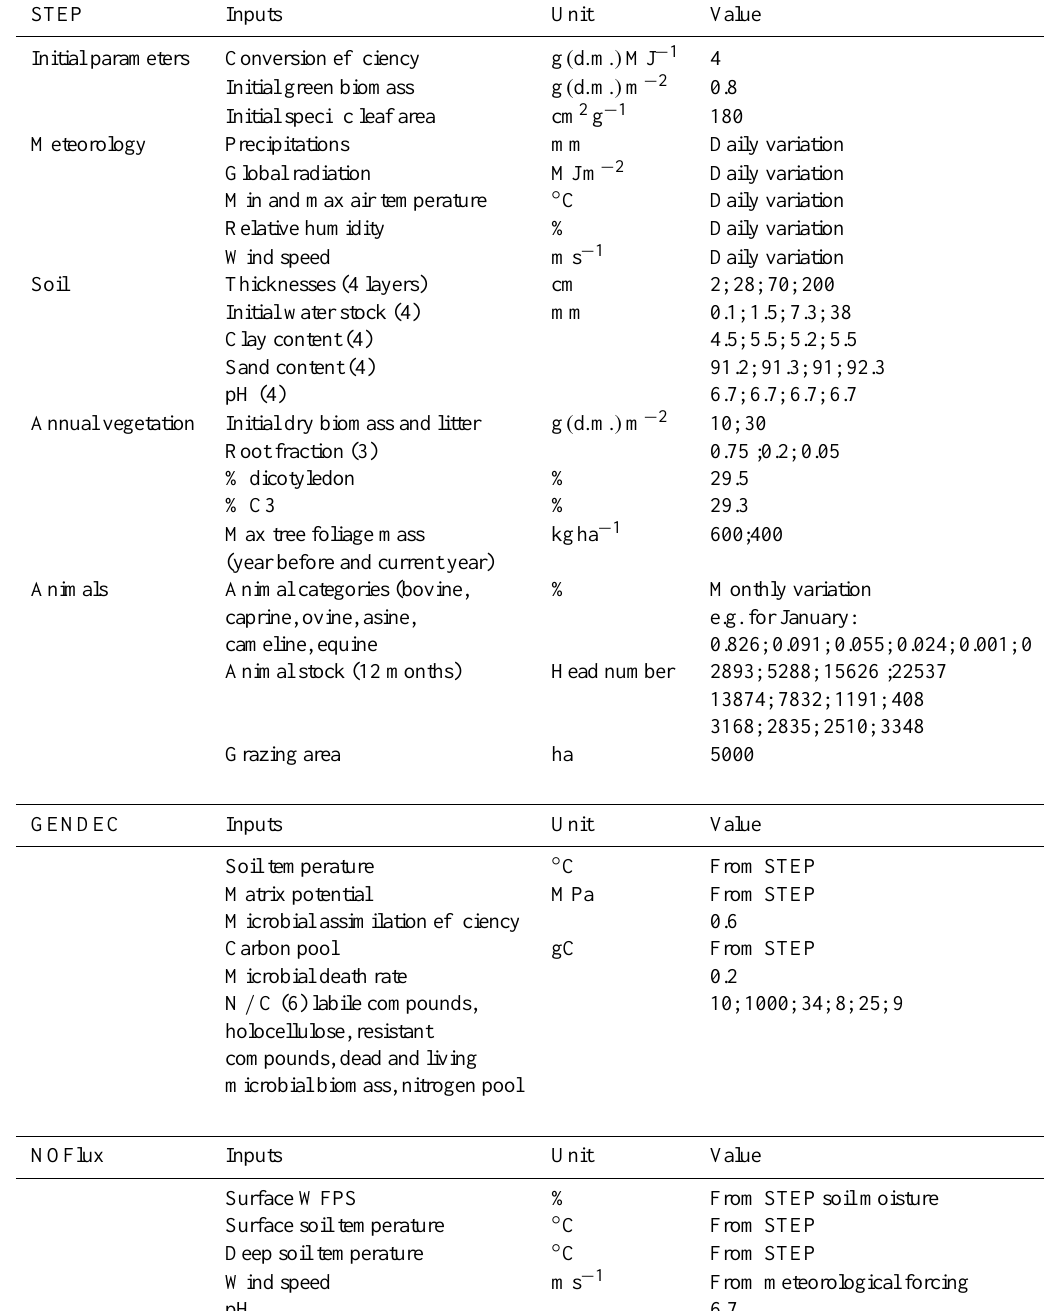
Table 1. Inputs for the models